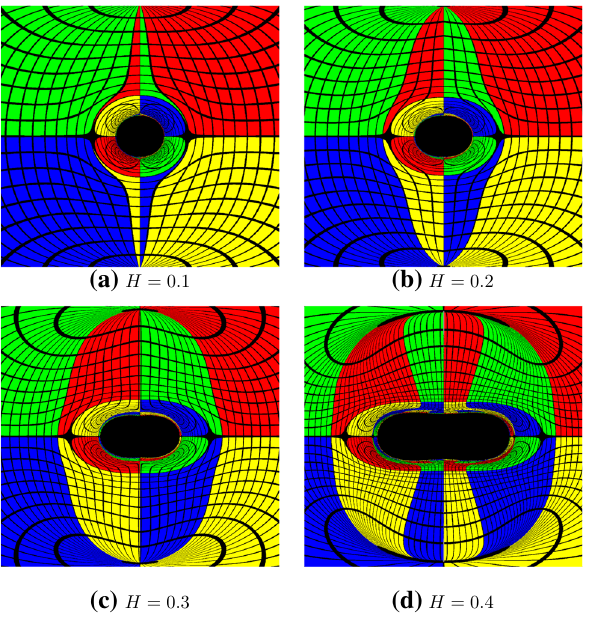
Fig. 6 Images for Schwarzschild black holes (the Minkowski space- time) in the left panel (right panel), immersed in Maxwell magnetic field (BI magnetic field) on the top panel (bottom panel). We set the black hole mass m = 1 for a and c , and the BI magnetic field strength H = 0 . 4for c and d .WhenBInonlineareffectsareconsidered,axisym- metric higher-orders images of the celestial sphere appear in c and d . It reveals that photons tend to move towards the axis of symmetry under the influence of the nonlinear effects immersed in Maxwell magnetic fields. When BI nonlinear